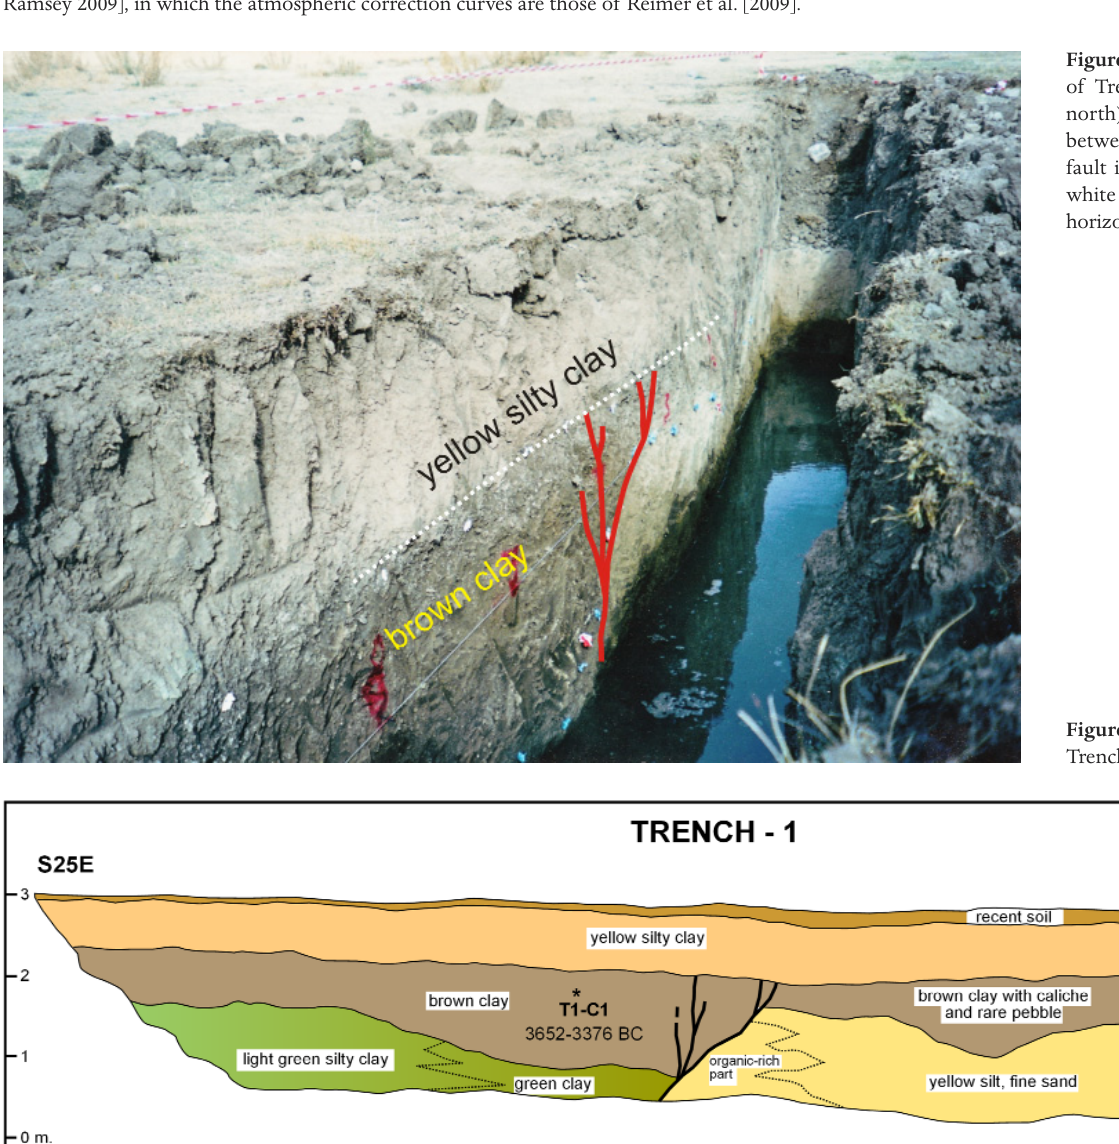
Table 2. Measured and calibrated radiocarbon ages from the collected samples. The measurements were calibrated using OxCal, version 4.1.7 [Bronk Ramsey 2009], in which the atmospheric correction curves are those of Reimer et al. [2009].